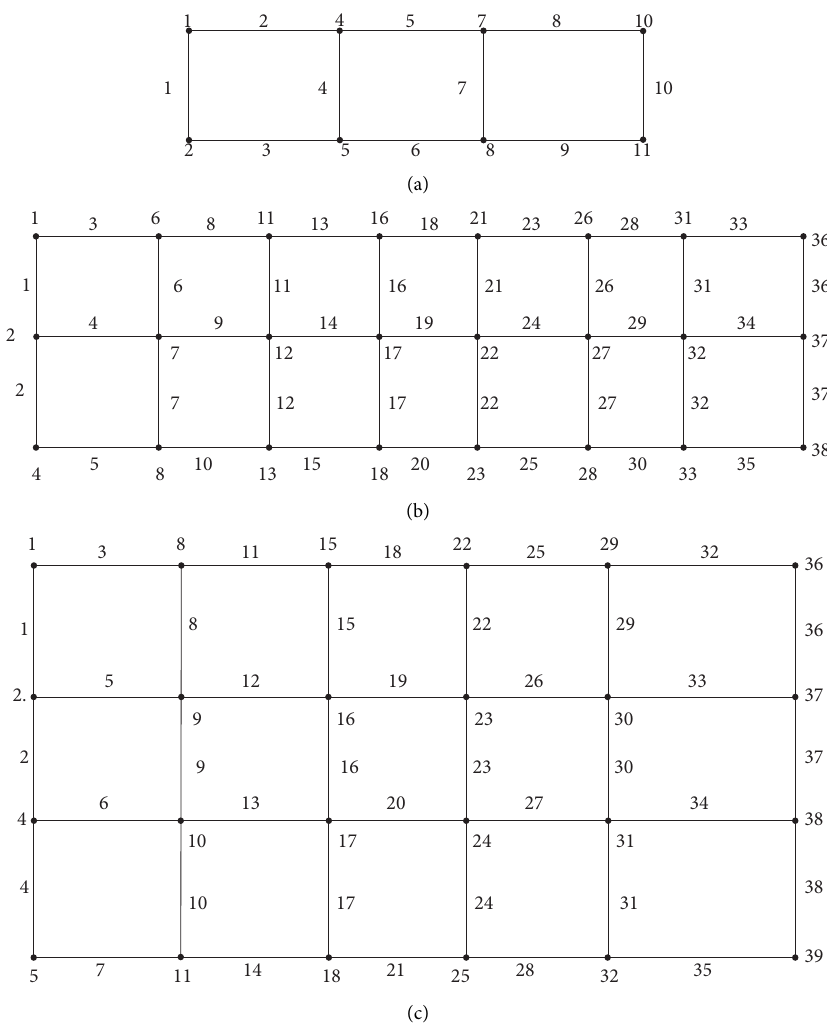
Figure 4: A classical mean labeling of P